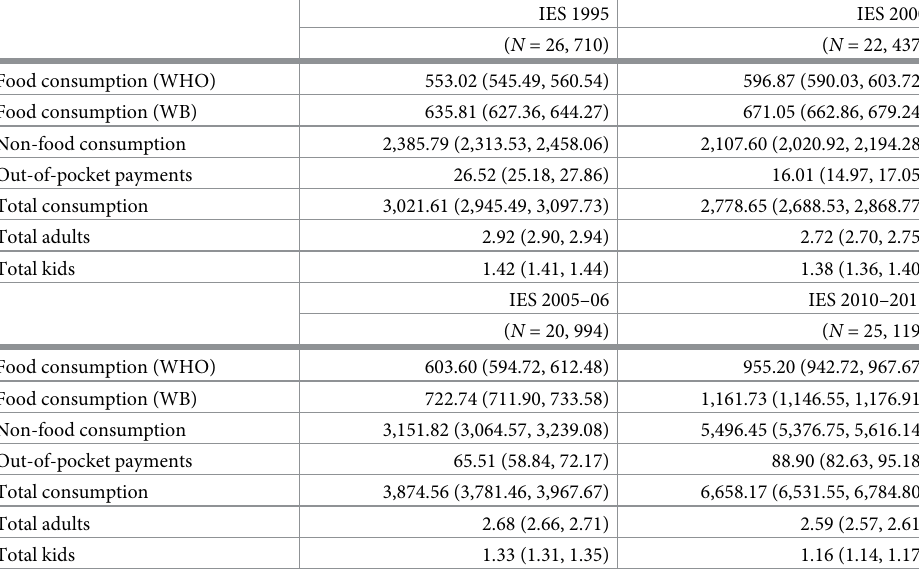
Table 1. Household structure and monthly expenditure